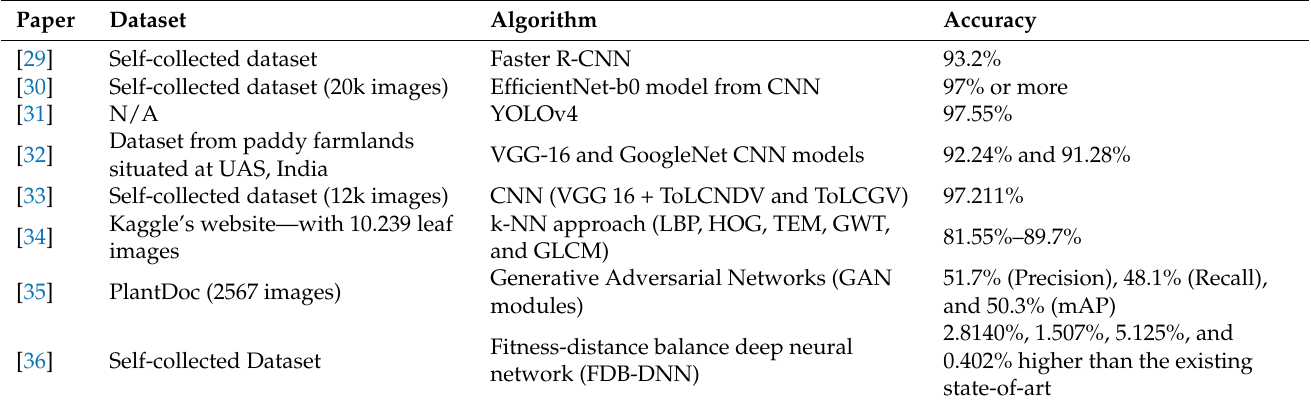
Table 3. Summary of the datasets and